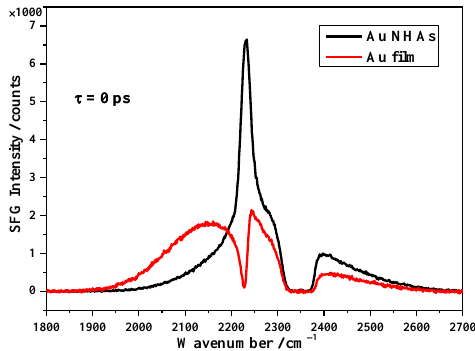
Figure 4. SFG spectra of 4-MBN on Au NHAs (black) at ϕ = 90° and flat gold film (red) at ~57° incident angle (with 1 mW VIS, 5 mW IR, and 30 s acquisition time).